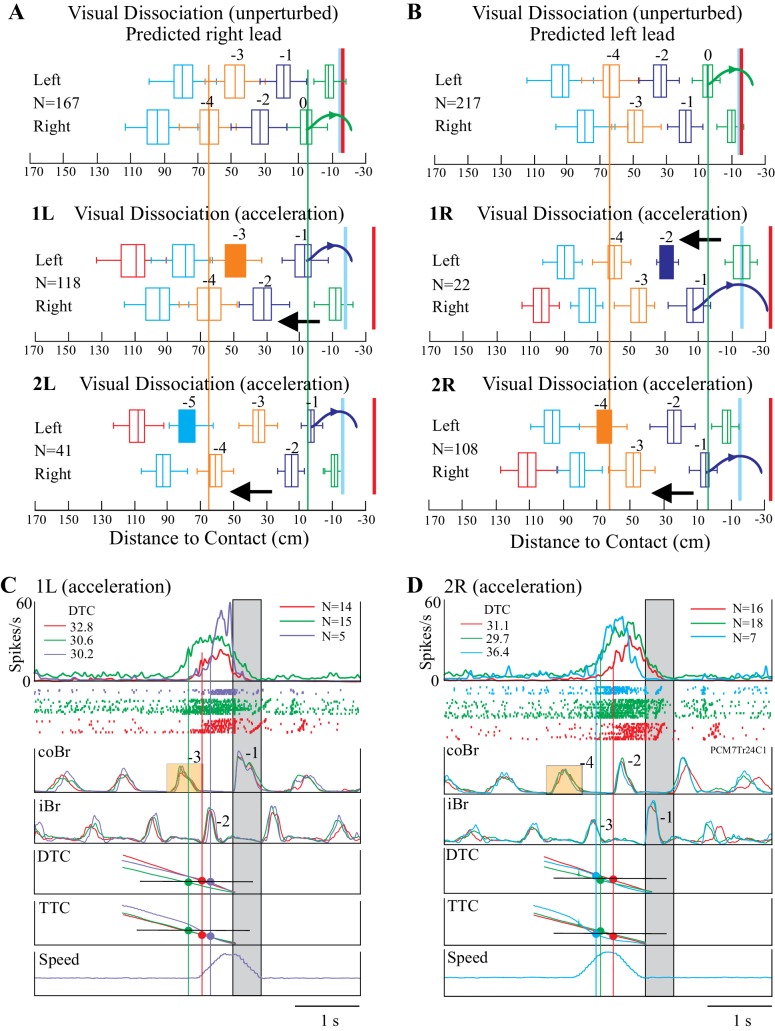
Effect of obstacle acceleration on behavior and cell discharge.A and B illustrate the distance of the cat from the obstacle at the onset of flexor muscle activity in the left and right limb lead condition (same representation as in Figure 1). The filled box indicates the step in which we applied the acceleration. The steps are color-coded to identify each step before the step over the obstacle together with the pairs of steps, organized in a right/left manner in A and left/right in B. The red vertical line indicates the approximate expected location of the obstacle in the absence of acceleration. The blue vertical line indicates the approximate position of the obstacle at the end of the acceleration. Note that the sequence of the steps reverses during the acceleration. Details are in the text. (C, D) organized as for Figures 3–4, with the bottom trace indicating the speed of the obstacle; note we applied the acceleration 200 ms after the onset of activity in the coBr. Data are shown for the matched (red), visual dissociation (green), and acceleration (purple, 1L or cyan, 2R) task. In C, accelerations correspond to those illustrated in the middle trace of A (1L condition) while in D they correspond to those illustrated in the bottom trace of B (2R condition). Small orange rectangles indicate the coBr burst used to trigger the acceleration and correspond to the colored boxes in A, B. Similarly, numbers beside the Br bursts correspond to the numbers identifying steps in A, B. Same cell as illustrated in Figure 3. (Figure 7—source data 1 and 2). Figure 7—figure supplement 1: Effect of acceleration on gait pattern. Figure 7—figure supplement 2: Relationship between time and distance for the visual dissociation and the 1L acceleration task. Figure 7—figure supplement 3: Relationship between time and distance for the visual dissociation and the 2R acceleration task.10.7554/eLife.28143.026Figure 7—source data 1.Source data for box plots in Figure 7A.10.7554/eLife.28143.027Figure 7—source data 2.Source data for box plots in Figure 7B.10.7554/eLife.28143.028Figure 7—source code 1.Script for data in Figure 7.